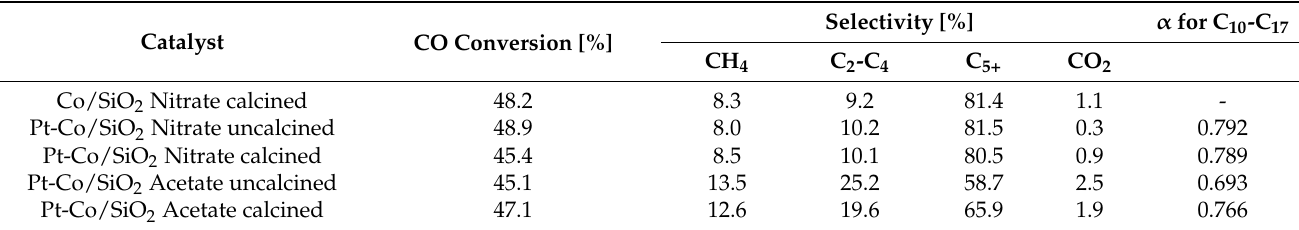
Table 5. CO conversion and product selectivity for the catalysts tested at similar CO conversions (process